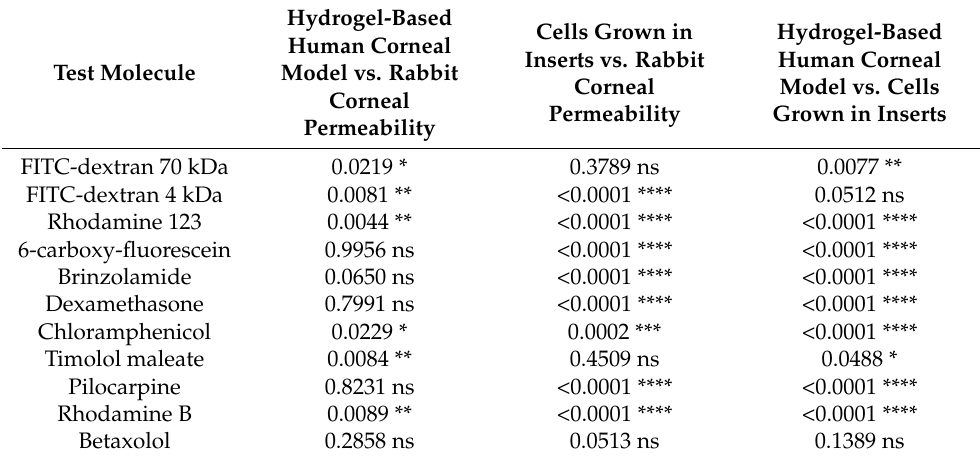
Table 3. Statistical comparison of P app values. Differences were considered to be statistically